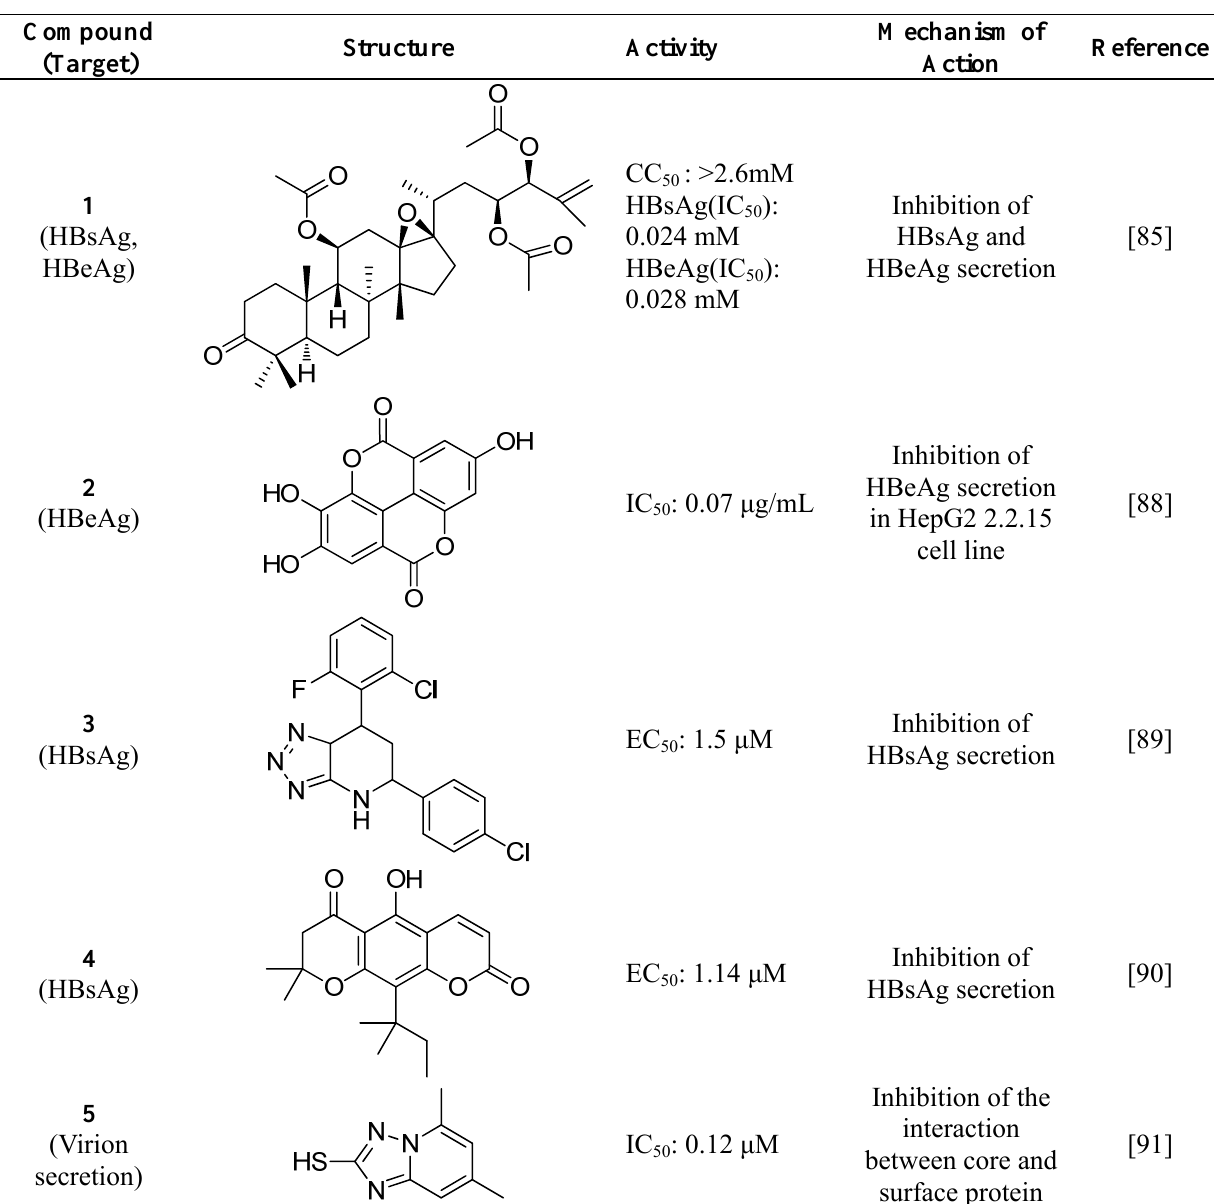
Table 3. Summary of non-nucleoside HBV inhibitors that target viral